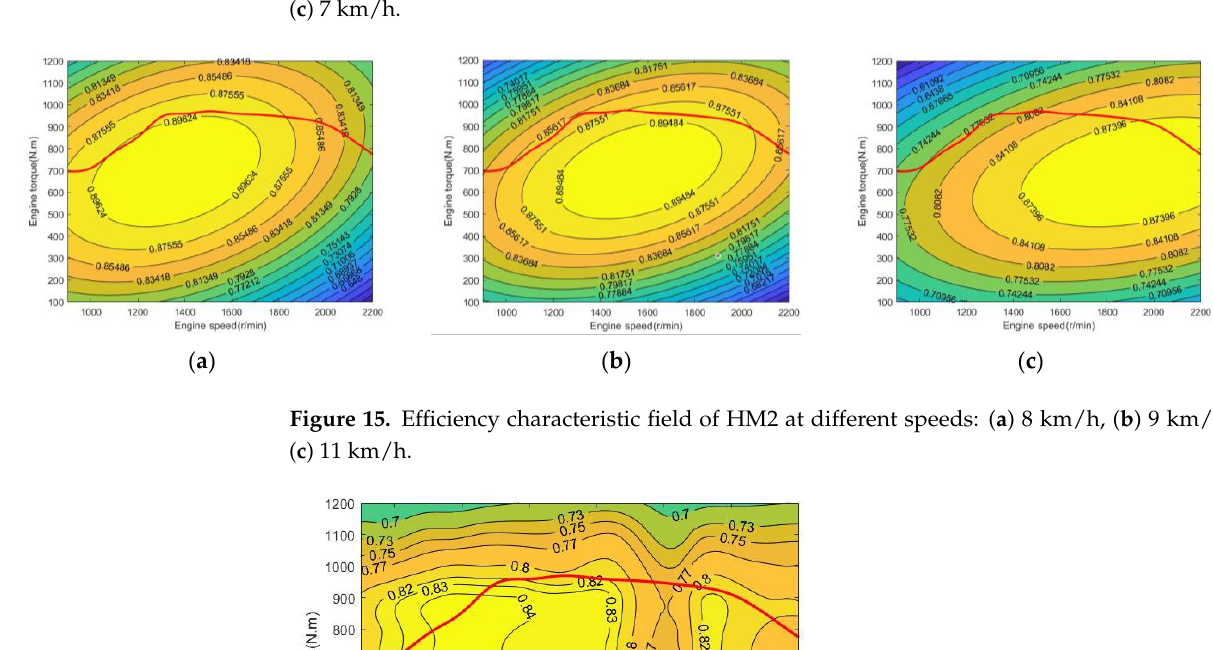
Figure 15. Efficiency characteristic field of HM2 at different speeds: ( a ) 8 km/h, ( b ) 9 km/h and ( c ) 11 km/h. Figure 14. Efficiency characteristic field of HM1 at different speeds: ( a ) 4 km/h, ( b ) 6 km/h and ( c ) 7 km/h.